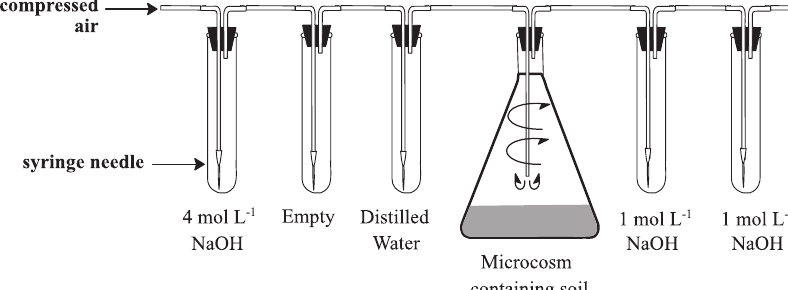
figure 1. purge-and-trap apparatus used to collect co 2 produced by soil